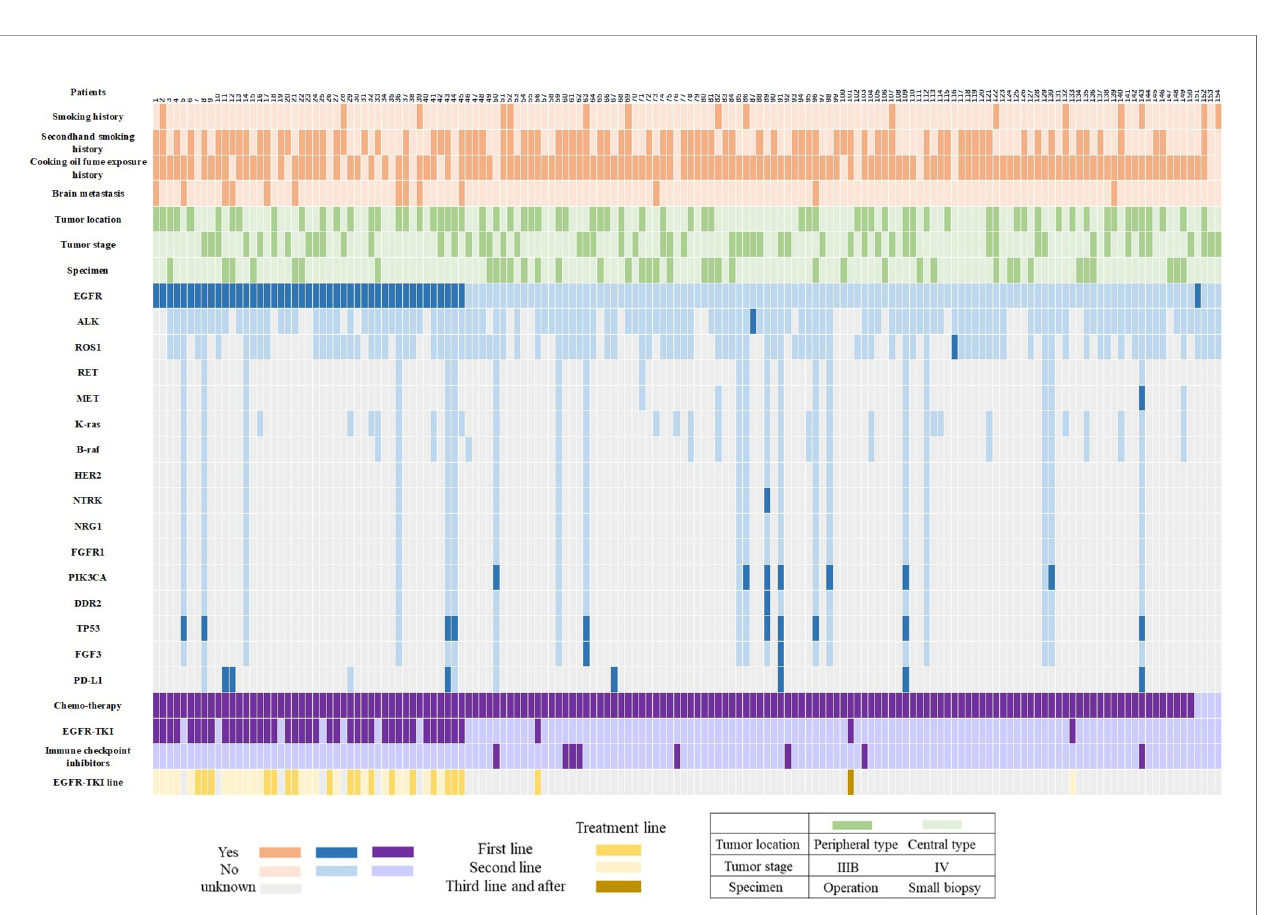
FIGURE 3 | Graphical distribution of the genomic pro fi le. PD-L1, programmed death ligand-1; EGFR-TKI, epidermal growth factor receptor -tyrosine kinase